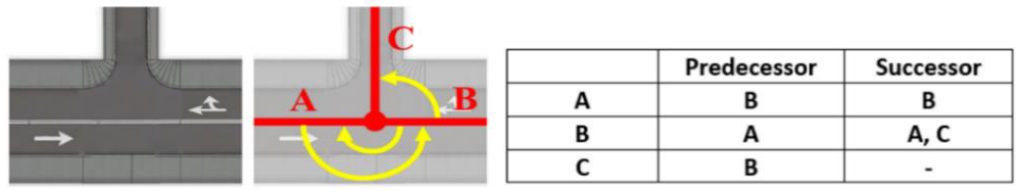
/ Successor Figure 8. Predecessor/Successor relations. Figure 8. Predecessor Figure 8. Predecessor/Successor relations.